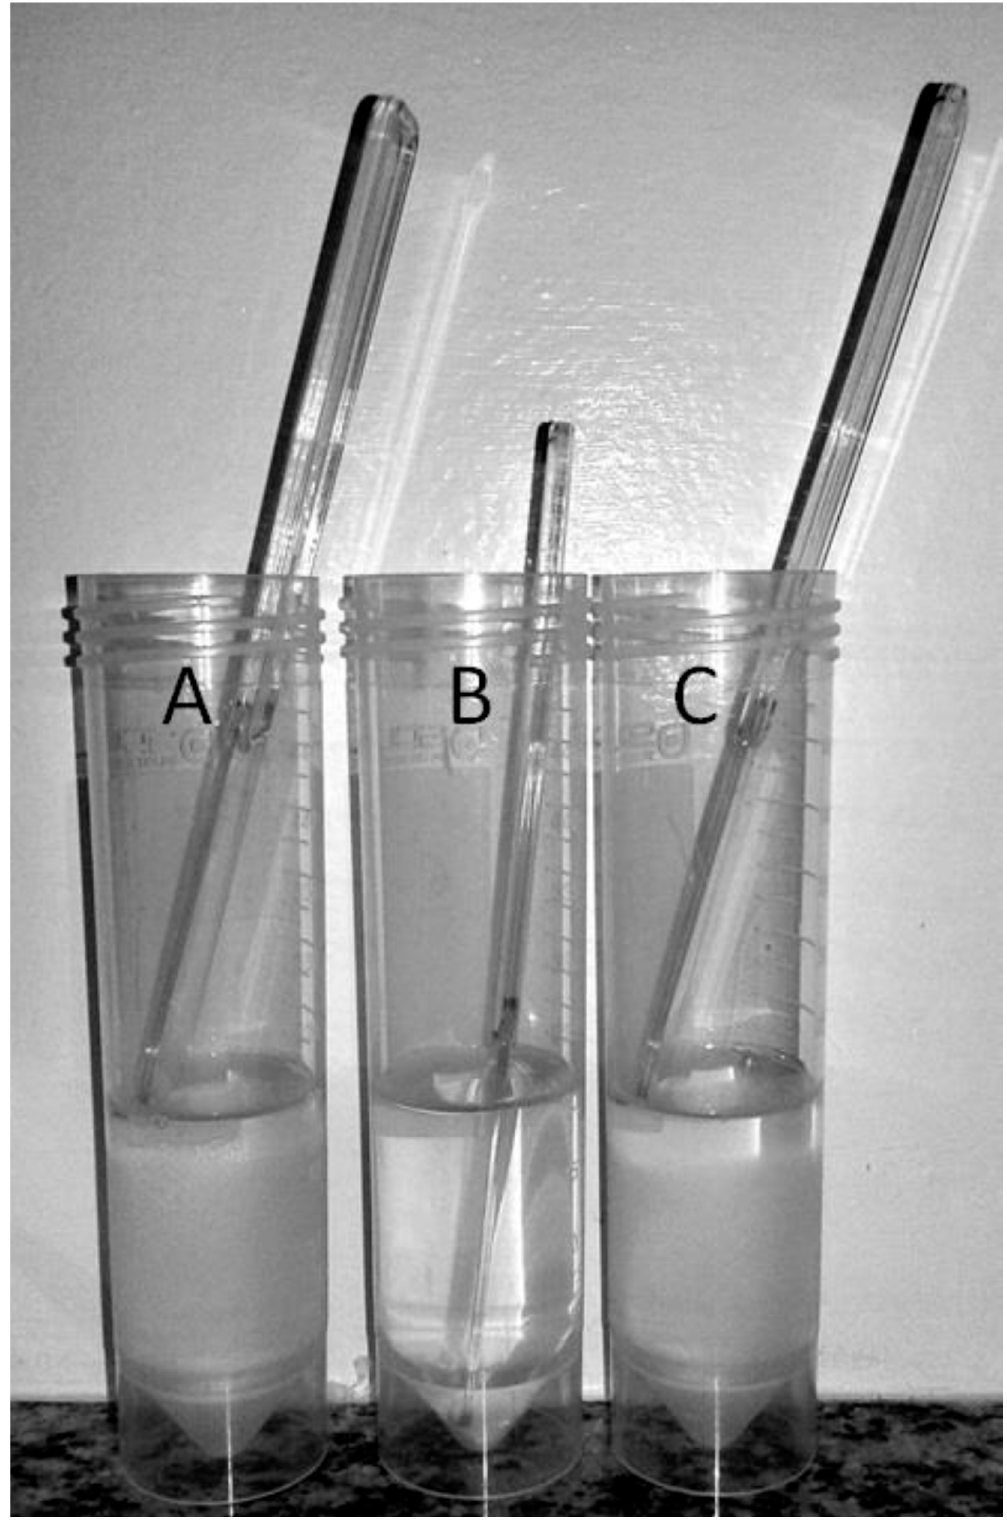
Figure 2. Thermal denaturation of bromelain. The experiment was done by adding pineapple juice to samples containing gelatin in sol (liquid) phase. After mixing, the samples were placed in refrigerator for 30 min. ( A ) Control experiment done by addition of water where gelatin is able to set (gel state); ( B ) effect of native bromelain in which the sample is liquid due to hydrolysis; ( C ) the thermal denatured bromelain does not hydrolyze the gelatin that becomes a gel upon refrigeration.